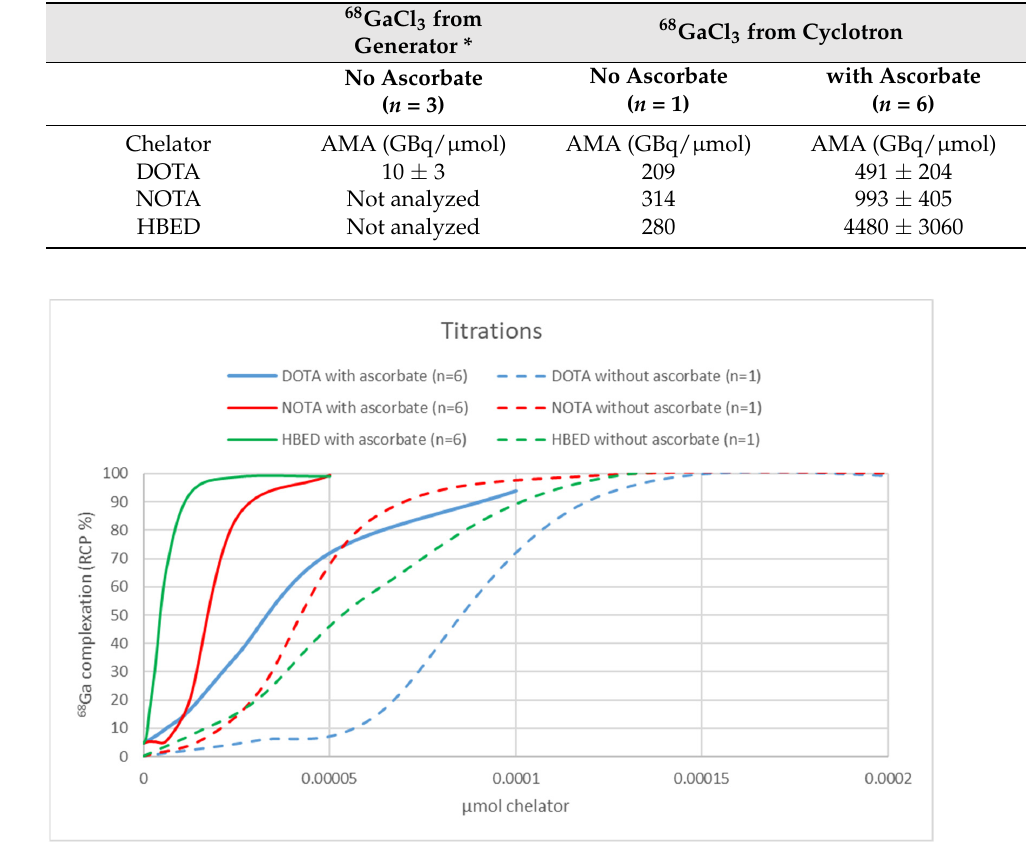
Figure 5. Comparison between DOTA, NOTA, and HBED titrations on 68 GaCl 3 productions with or without sodium ascorbate addition to the dilution and wash solutions in the purification